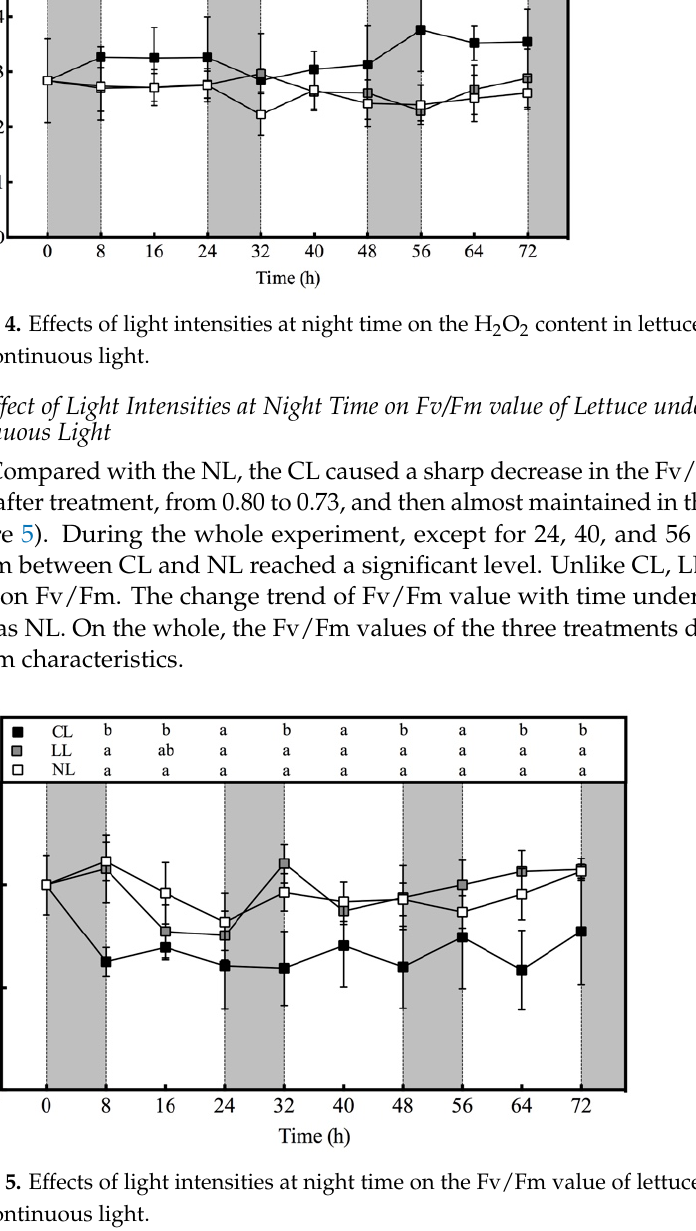
blue continuous and blue continuous light.